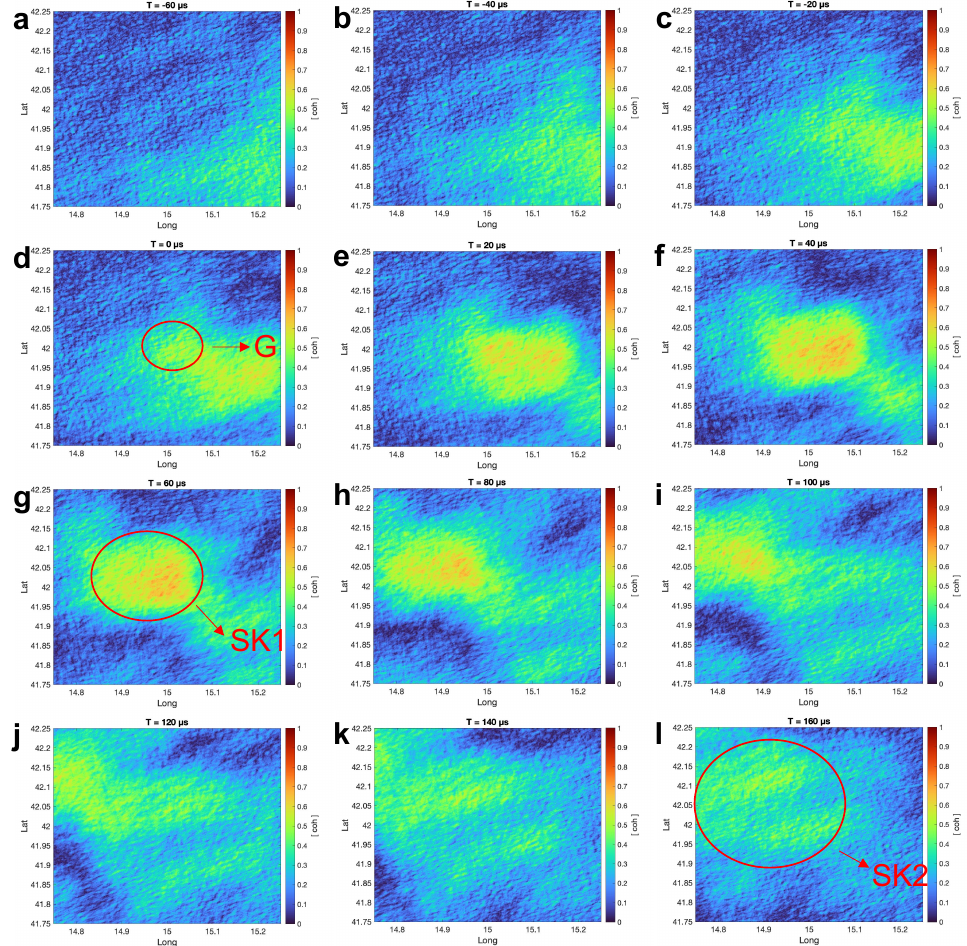
Figure 7. The coherency maps with 105 receiver network with a simulated lightning location of 15°E and 42°S. Each sub-figure ( a – l ) is the coherency map at a different